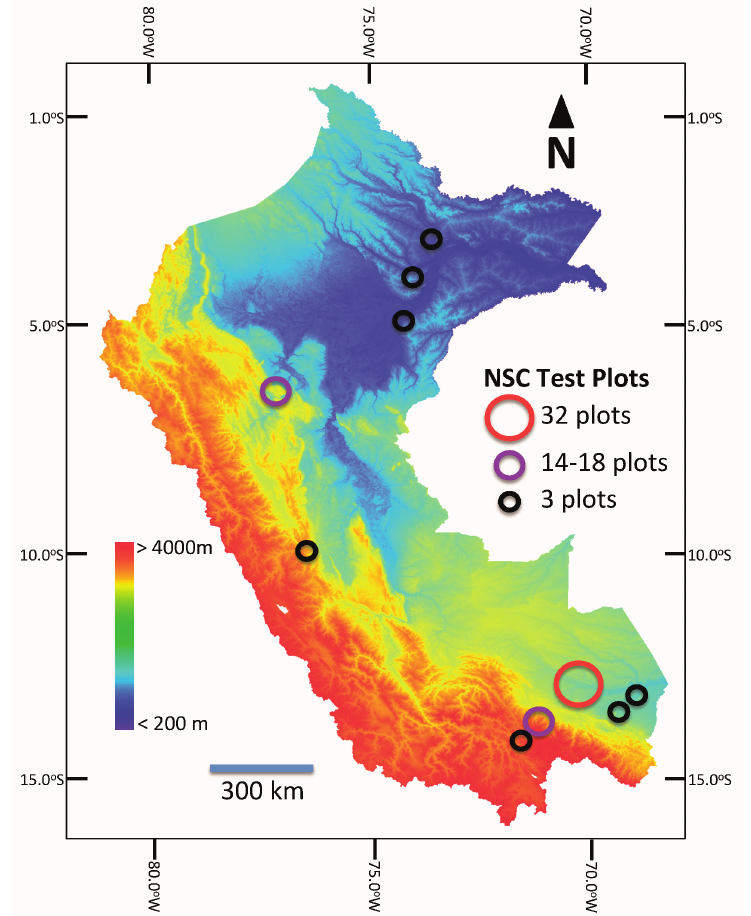
Figure 3. The regional distribution of one-hectare field plots in the Amazon basin and Andean forests of Peru. The map is a digital elevation model (DEM) of Peru derived from NASA Shuttle Radar Topography Mission (SRTM) data. Circles contain clusters of field plots as indicated and are arrayed geographically to maximize environmental and floristic variation as reported by Asner et al.